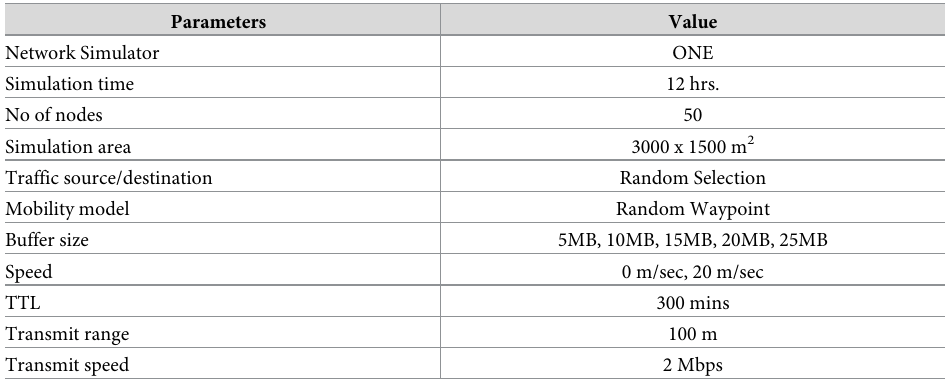
Table 2. Simulation